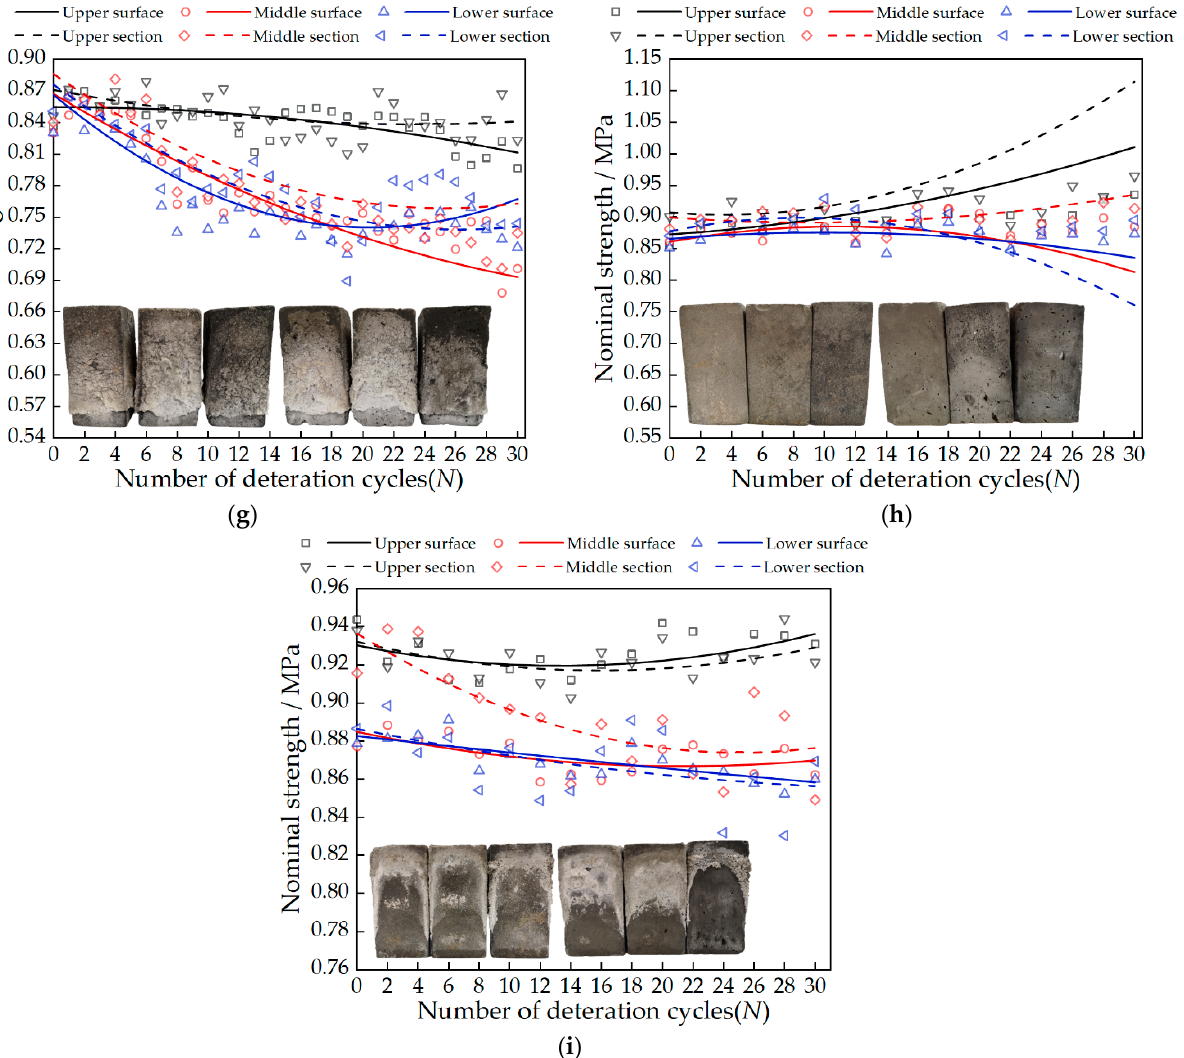
Figure 5. Fitting curve of nominal strength of different test samples: ( a ) A 1 B 1 C 1 ; ( b ) A 2 B 3 C 1 ; ( c ) A 3 B 2 C 1 ; ( d ) A 1 B 2 C 2 ; ( e ) A 2 B 1 C 2 ; ( f ) A 3 B 3 C 2 ; ( g ) A 1 B 3 C 3 ; ( h ) A 2 B 2 C 3 ; ( i ) A 3 B 1 C 3 .